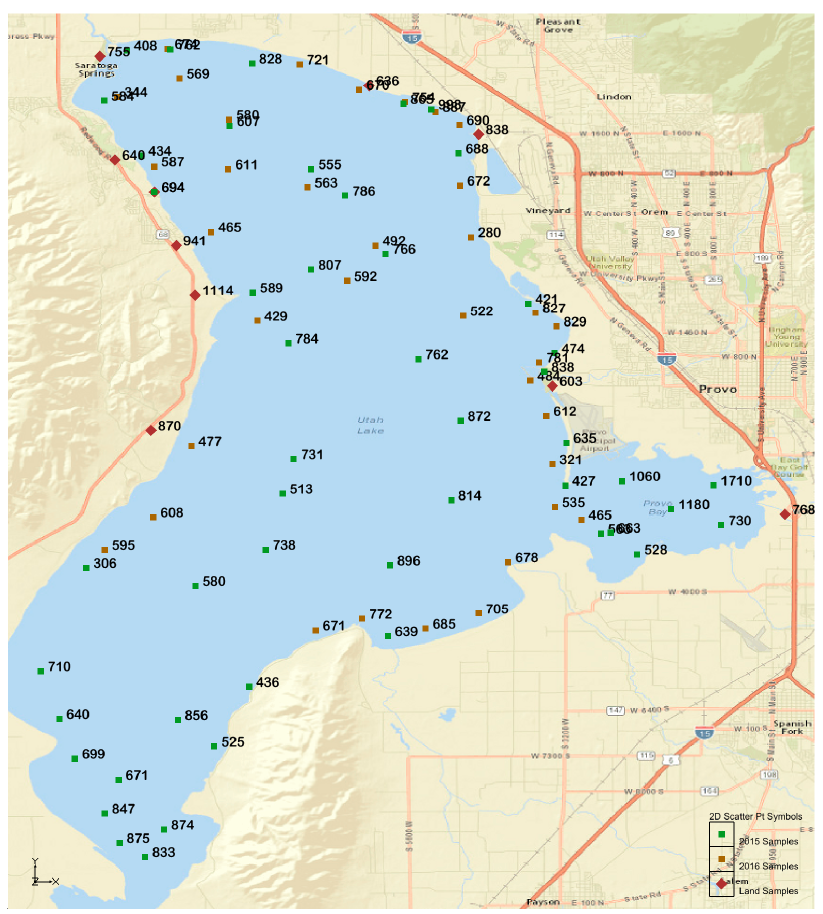
Figure 5. Total phosphorus in ppm at each sample point. Some points between 2015 and 2016 are close and labels overlap. The map is not to